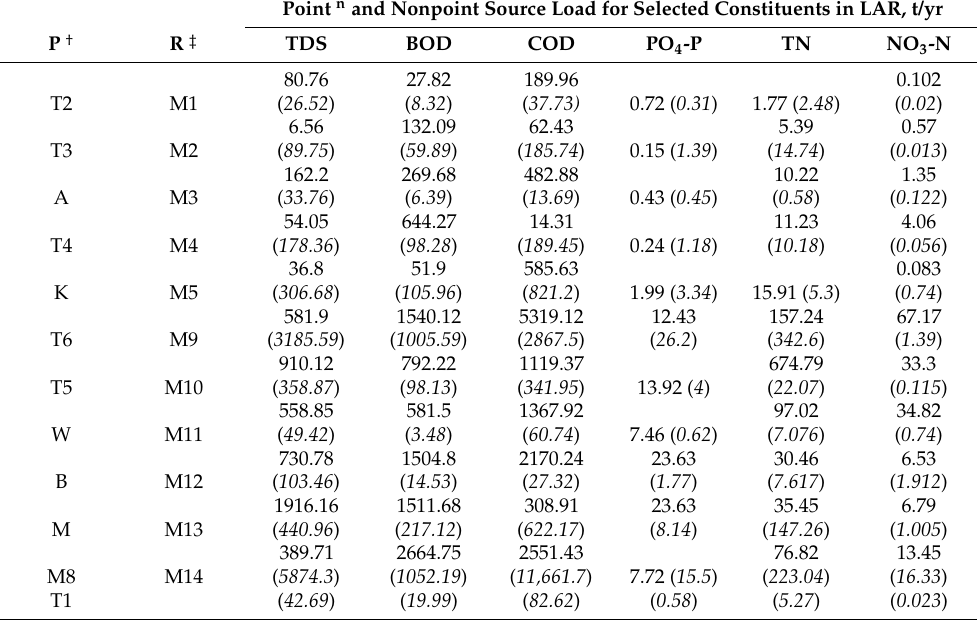
Table 3. Summary of annual point and nonpoint source load for selected constituents in LAR